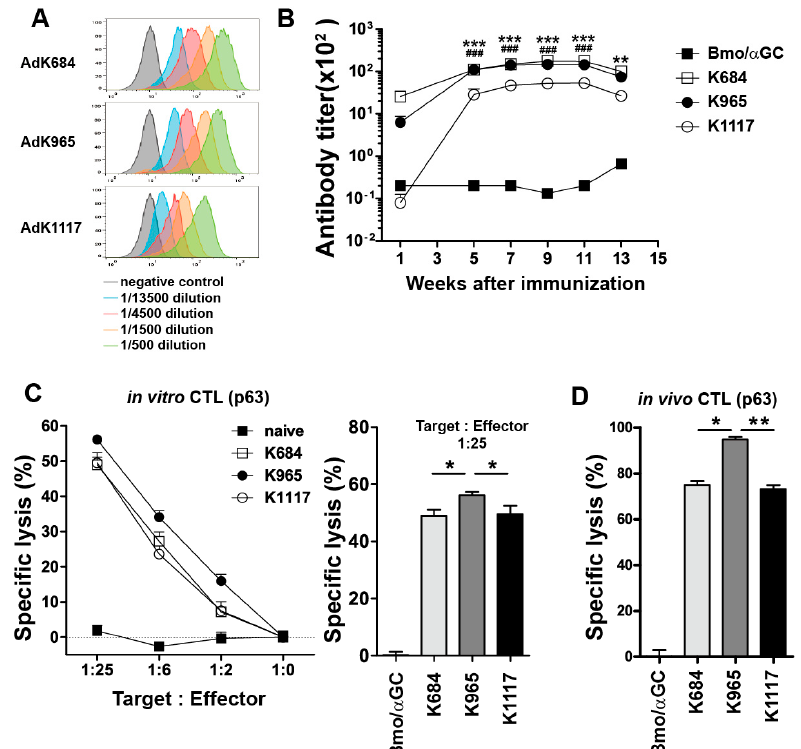
Figure 2. The analysis of the antibody response in the sera of vaccinated mice. ( A , B ) Naïve BALB / c mice were immunized with B cell and monocyte-based vaccine transduced by modified adenovirus carrying each antigen. One, 5, 7, 9, 11, and 13 weeks after immunization, antibodies in the mouse sera were titrated by flow cytometry (* p < 0.05, ** p < 0.01, *** p < 0.001 for K684 versus K1117, ### p < 0.001, for K965 versus K1117). In vitro and in vivo cytotoxic T lymphocyte (CTL) analysis. Naïve BALB / c mice were immunized with B cell and monocyte-based vaccine transduced by modified adenovirus carrying each antigen. The splenocytes from immunized mice were co-cultured with attenuated CT26 / HER2 cell lines on day 7. After 5 days CD8+ T cells were sorted by microbeads and cocultured with 51 Cr-labeled P63 target peptide-loaded WEHI-164 cells ( C ). For in vivo CTL analysis, naïve BALB / c mice were immunized with B cell and monocyte-based vaccine transduced by modified adenovirus carrying each antigen. HER2 P63 peptide-loaded target cells and unloaded internal control cells labeled with CFSE high and low, respectively, were injected into immunized mice. One day after target cell injection, all mice were sacrificed, and specific cell lysis was analyzed with flow cytometry ( D ). (* p < 0.05, ** p < 0.01, *** p < 0.001).